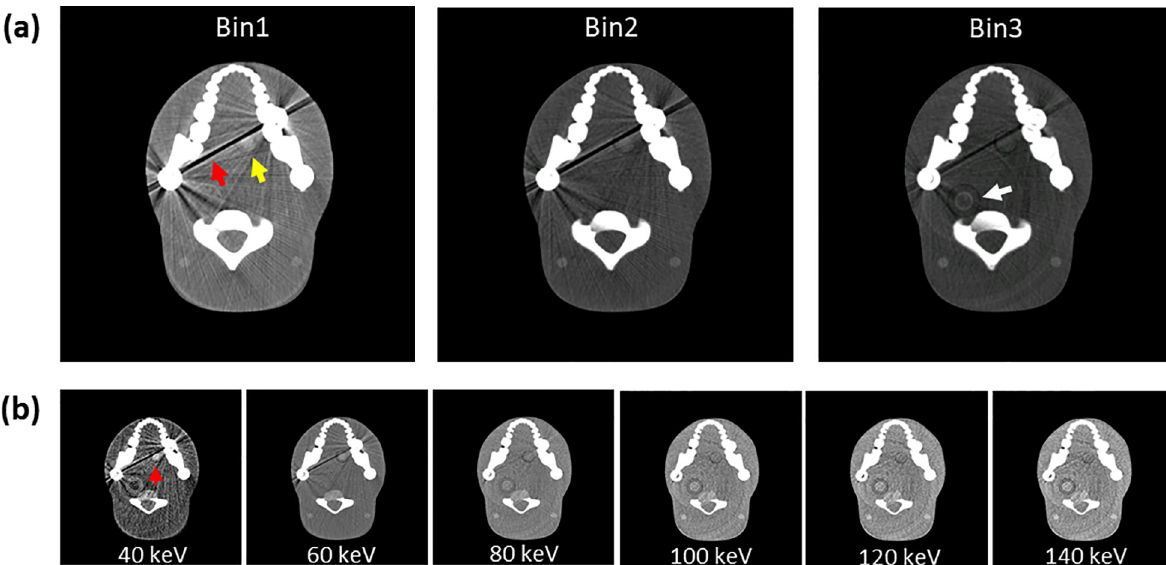
Fig 7. Multi-energy bin 1, bin 2, and bin 3 images acquired from the PCD CT system. VMI was created using three acquired images. (a) The higher the energy from bin 1 to bin 3, the smaller the metal artifact (red arrow). Compared with bin 2 and bin 3, bin 1 (yellow arrow) shows enhanced iodine in the oral tumor portion. (b) VMI from 40 keV to 140 keV created from three energy bin images reconstructed from an iodine- enhanced ATOM phantom with a left oral tumor (red arrow). VMIs of the same scan/slice are shown at 40, 60, 80, 100, 120, and 140 keV. Display window: W/L = 600/150